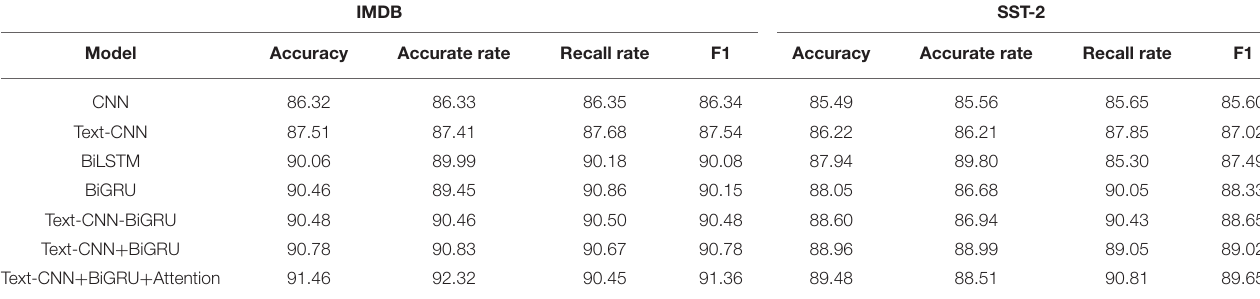
TABLE 8 | Experimental results of different